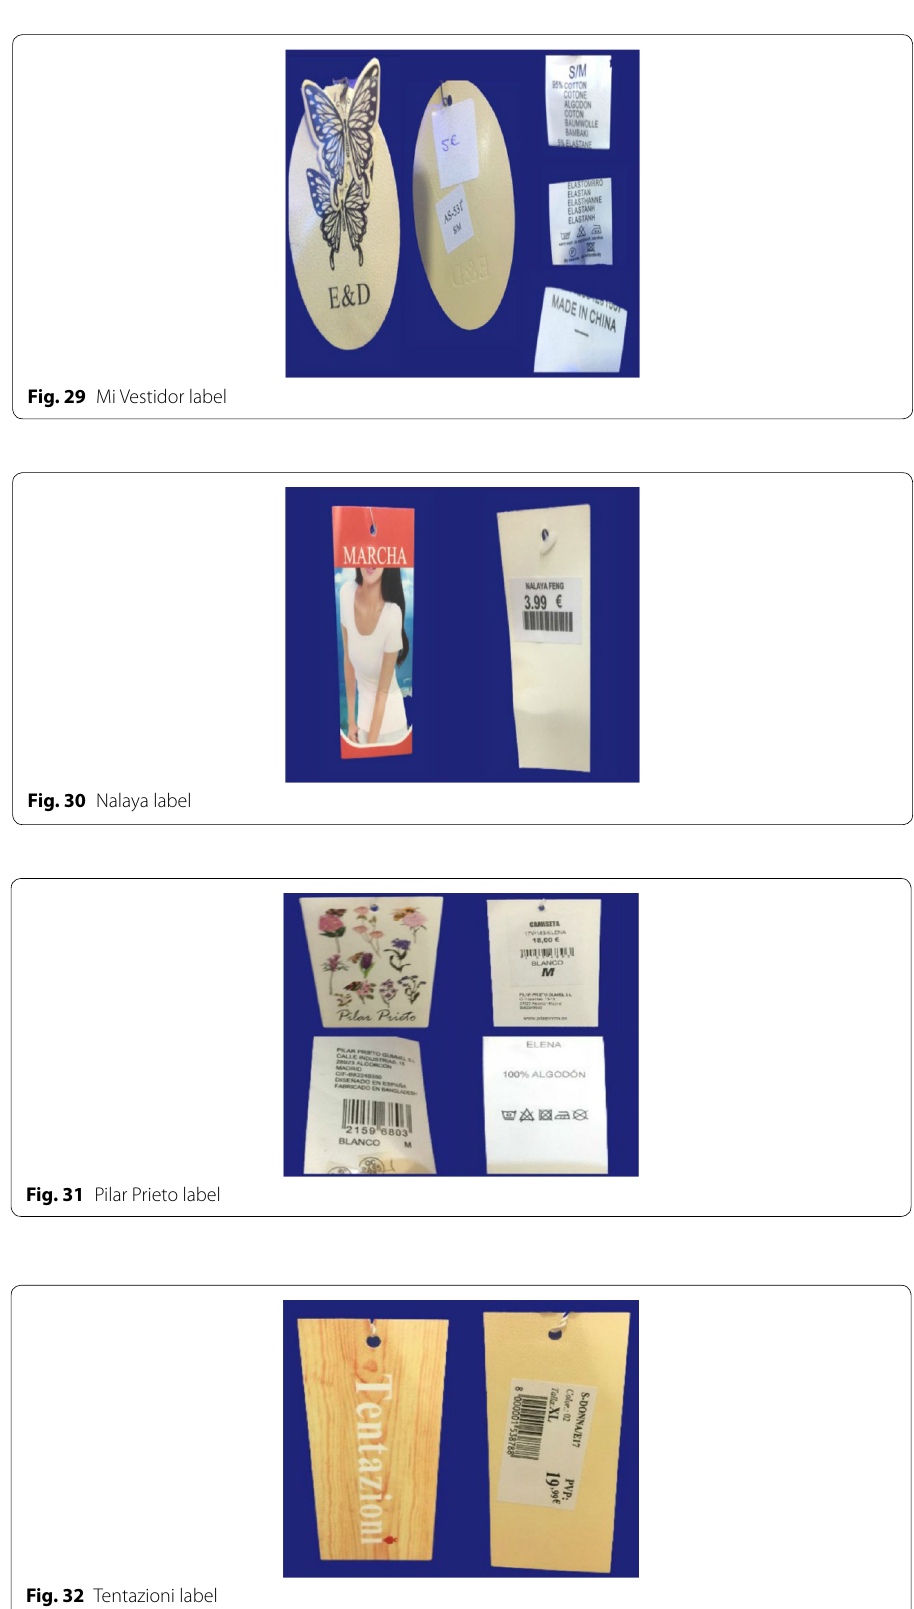
Fig. 32 Tentazioni